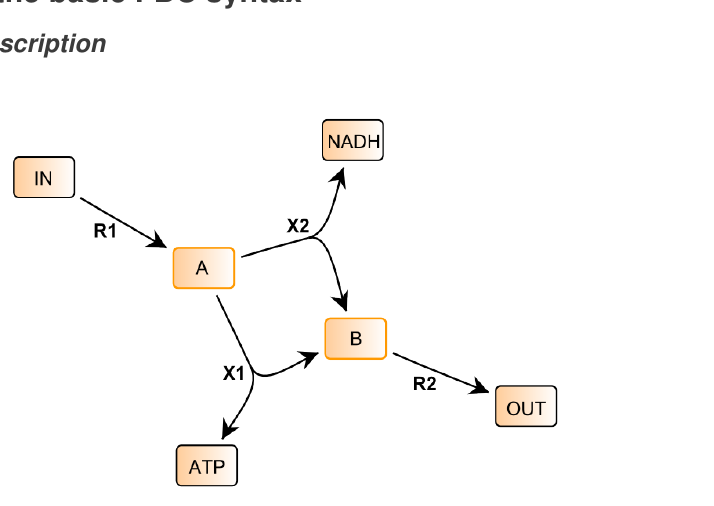
Figure 6: FBC syntax example: a simple four reaction pathway. The reactions are R1, R2, X1, X2 with fixed species IN, OUT, ATP, NADH and variable species A, B.